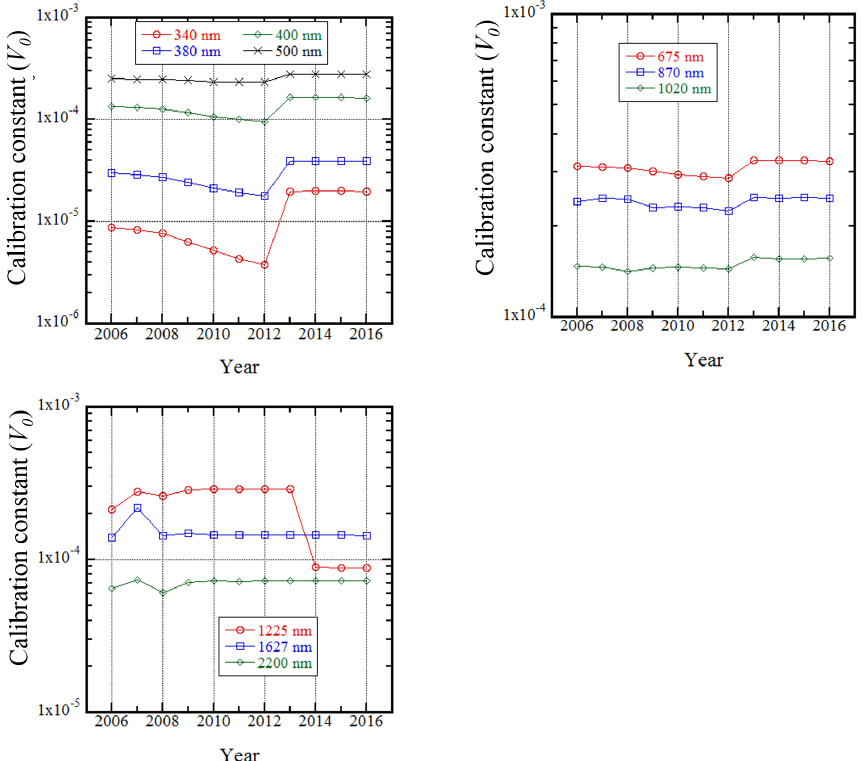
Figure 5. Annual variation of the calibration constants ( V 0 ) for POM-02 (calibration reference). The sensor output of POM-02 is current. The unit of V 0 is ampere